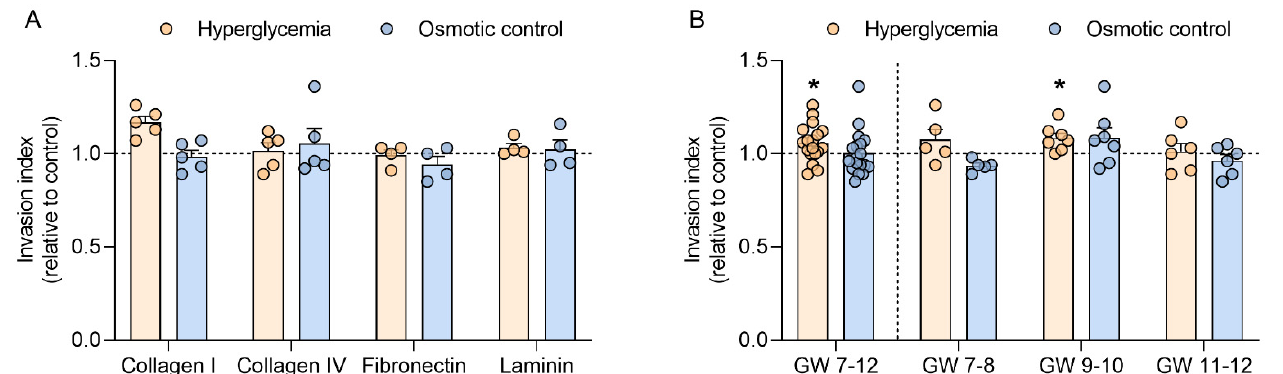
Figure 4. Hyperglycemia increases trophoblast invasion in mid-early pregnancy. Primary human first trimester trophoblasts (gestational week (GW) 7–8, n = 5; GW 9–10, n = 7; GW 11–12, n = 6) were cultured in absence (control) or presence of 25 mM D-glucose (hyperglycemia) and 5.5 mM D-glucose + 19.5 mM D-mannitol (osmotic control) for 48 h. Trophoblast invasion was quantified using a Transwell assay with four different extracellular matrices: collagen I, collagen IV, fibronectin, and laminin ( A ). Invasion data from the different matrices were pooled and also analyzed for different GW periods ( B ). Results were expressed as invasion index and calculated relative to the control, arbitrarily set to 1. Each condition was assayed in quadruplicates. Data are presented as mean ± SEM. Statistical analysis used Wilcoxon signed rank test. * p < 0.05 vs. control.